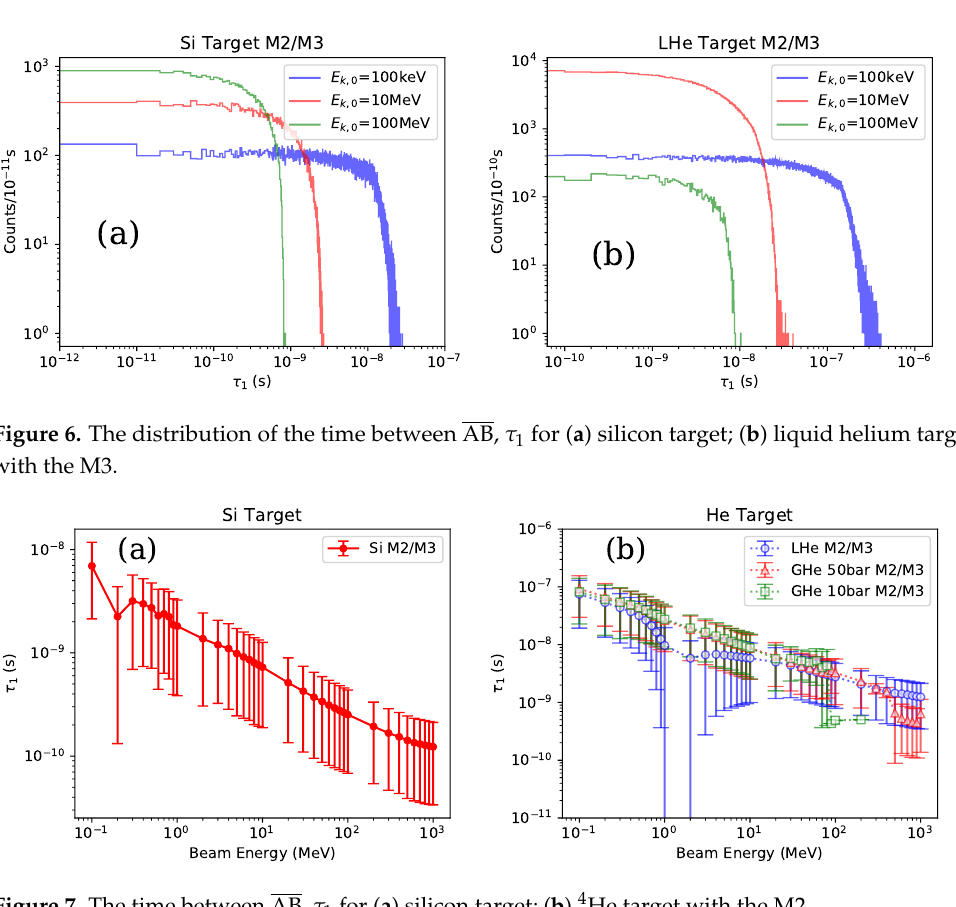
Figure 7. The time between AB, τ 1 for ( a ) silicon target; ( b ) 4 He target with the M2. Figure 8 shows the distribution of the ion energy with the momentum (cid:126) Q 1 and (cid:126) Q 2 . Figure 9 shows the average ion energy with the momentum (cid:126) Q 1 and (cid:126) Q 2 , which is equal to